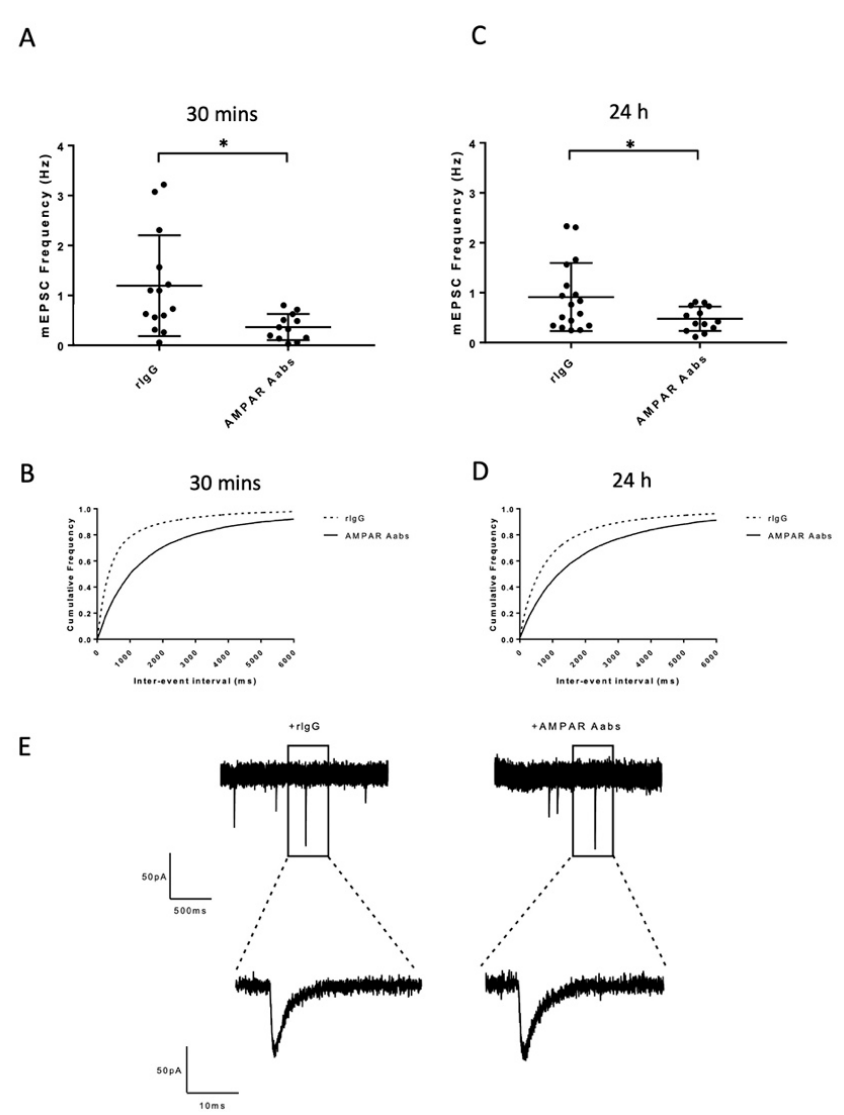
Figure 5. Effects of acute (30 min) and 24 h anti-AMPAR Aabs and rIgG application on mEPSC frequency and amplitude. ( A ) Anti-AMPAR Aabs had a significantly lower mean mEPSC frequency than rIgG treated cells over the 30 min period ( p < 0.05). ( B ) Anti-AMPAR Aabs had a significantly lower mean mEPSC frequency than rIgG treated cells following 24 h incubation ( p < 0.05). Significant differences in cumulative inter-event interval frequency were also observed for anti-AMPAR Aabs compared to rIgG incubated cells for ( C ) 30 min incubation and ( D ) following 24 h incubation (both p < 0.0001). Data were collected over three separate neuronal cultures, presented as mean ± SD and analysed by unpaired t -tests ( A , C ), or via Kolmogorov–Smirnov test ( B , D ). ( E ) Selected raw sEPSC traces for rIgG- and AMPAR-treated cells. * = p <